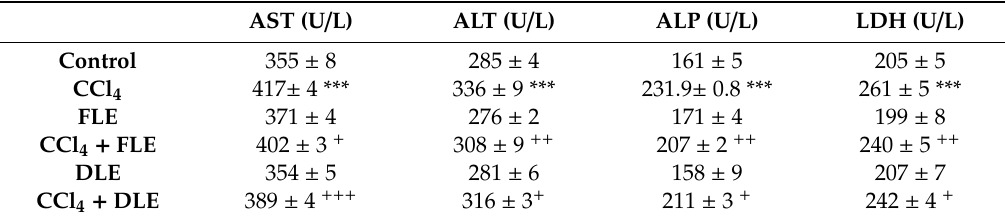
Table 2. E ff ect of CCl 4 , FLE and DLE administration on hepatic biochemical